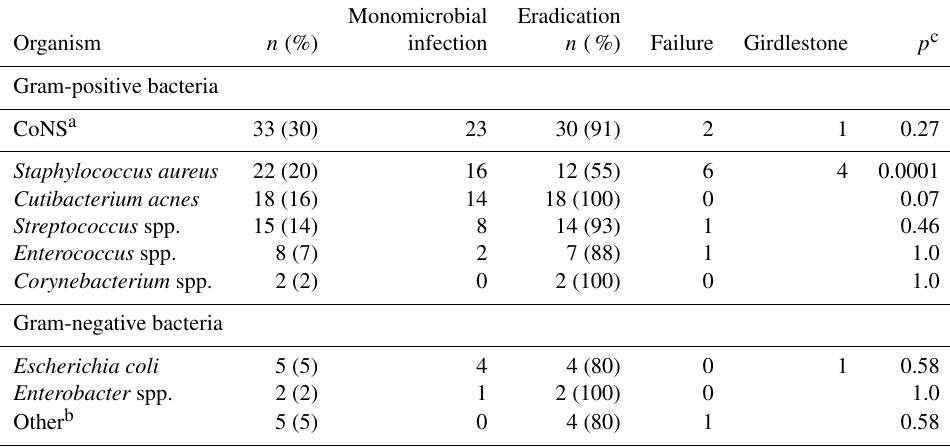
Table 2. Isolated microorganisms in 89 revised periprosthetic hip joint infections. The number of cultures was 110 since significant growth ( ≥ two tissue samples) of more than one bacterium was noted in 21 patients. Cultures in patients with repeated surgery and the same bacterial strains have only been counted